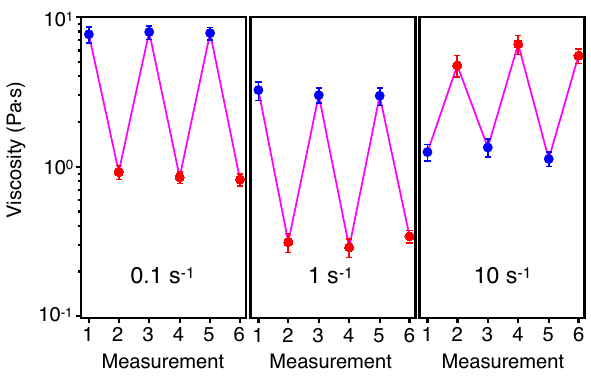
Fig. 6 Thermo-switchable shear-thickening system. Viscosity measurements at shear s of 0.1 s − 1 (left), 1 s − 1 (middle), and 10 s − 1 (right) of RB_0.52_PNIPAM at 20 °C; ϕ = 63% (blue) and 40 °C; ϕ = 46% (red). Error bars represent the standard deviations from ten